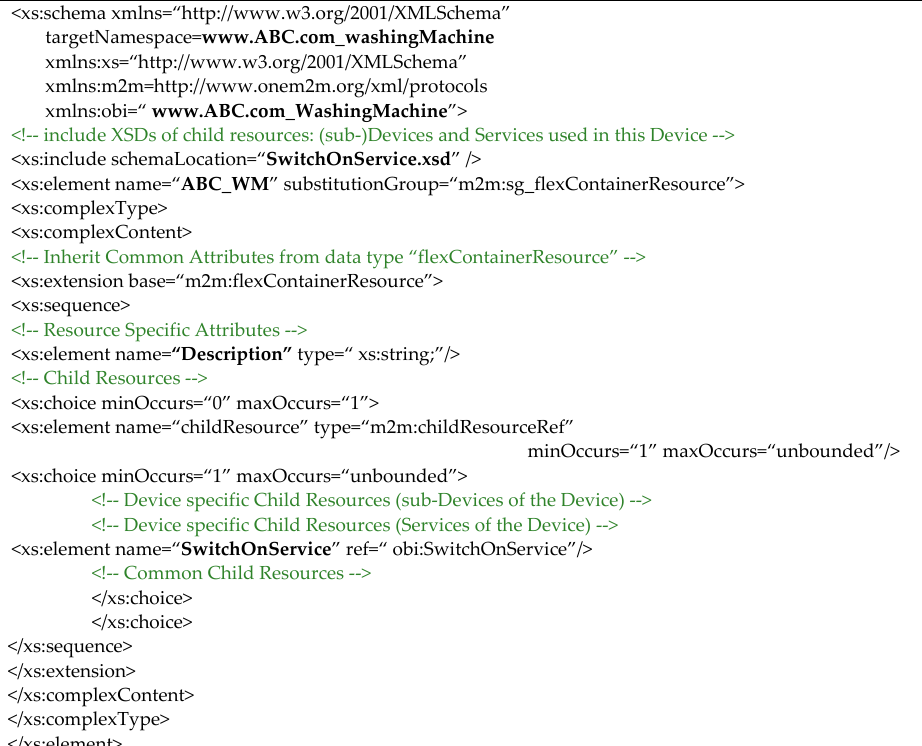
Figure 9. Common Ontology between oneM2M Base Ontology and SAREF-based Washing Machine Ontology. On the basis of this common ontology, XSD files relevant to the interworked device and the service may be created. For example, Figure 10 shows the XSD schema defined for the interworked device aimed to represent the ABC: ABC_WM class as a <flexContainer> oneM2M resource.